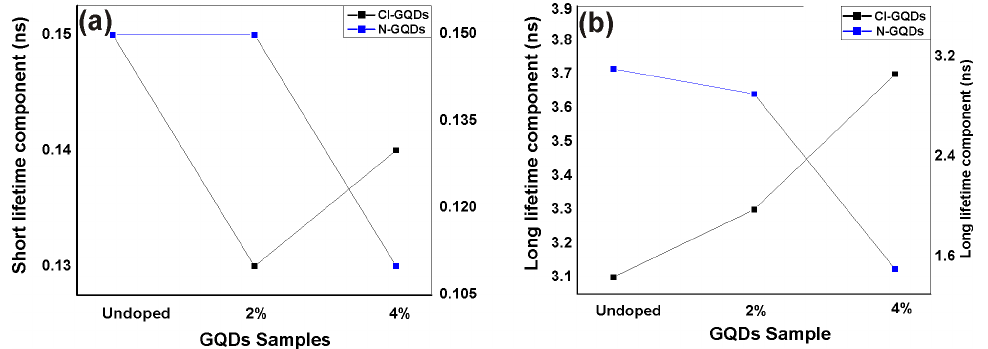
Figure 7. ( a ) Trend of short lifetime component of undoped Cl-GQDs and N-GQDs; ( b ) Trend of long lifetime component of undoped Cl-GQDs and N-GQDs.